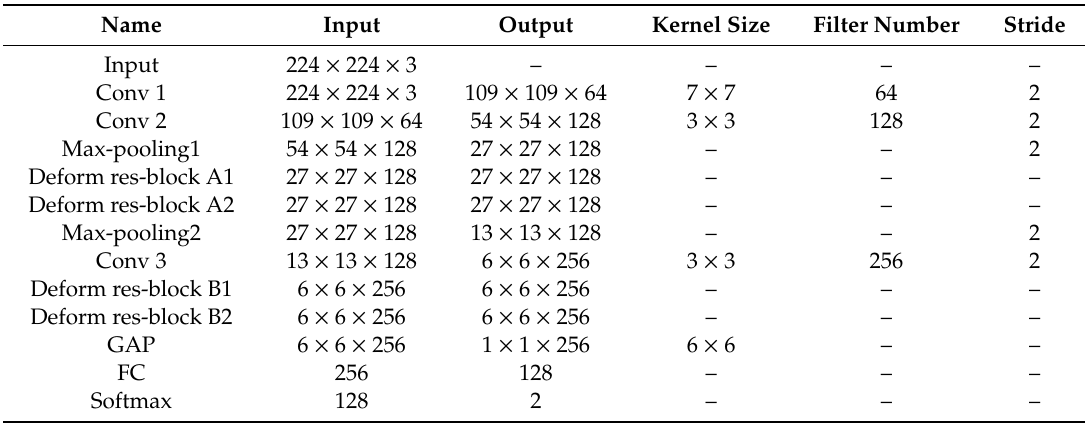
Figure 6. Structure of the multi-scale deformable CNN. Table 1. Detailed parameters of the multi-scale deformable CNN.